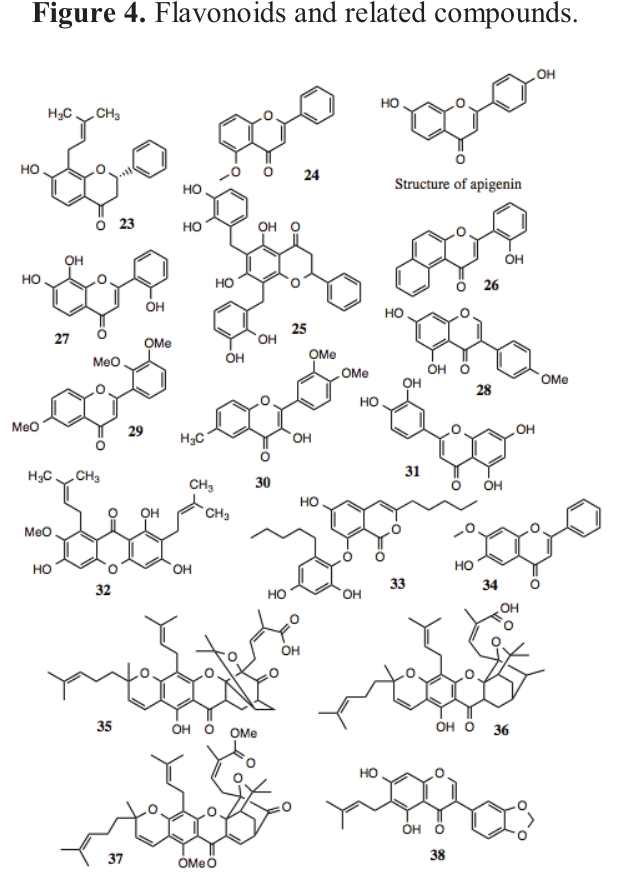
Figure 4. Flavonoids and related